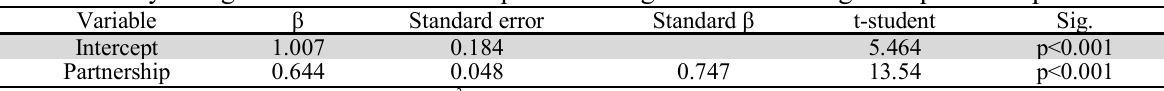
The summary of regression model between perceived organizational change and partnership Variable β Standard error Standard β t-student Sig. Intercept 1.007 0.184 5.464 0.001<p Partnership 0.644 0.048 0.747 13.54 0.001<p